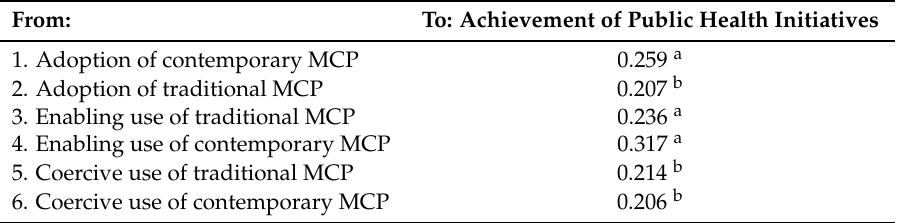
Table 5. Results from PLS analysis (path